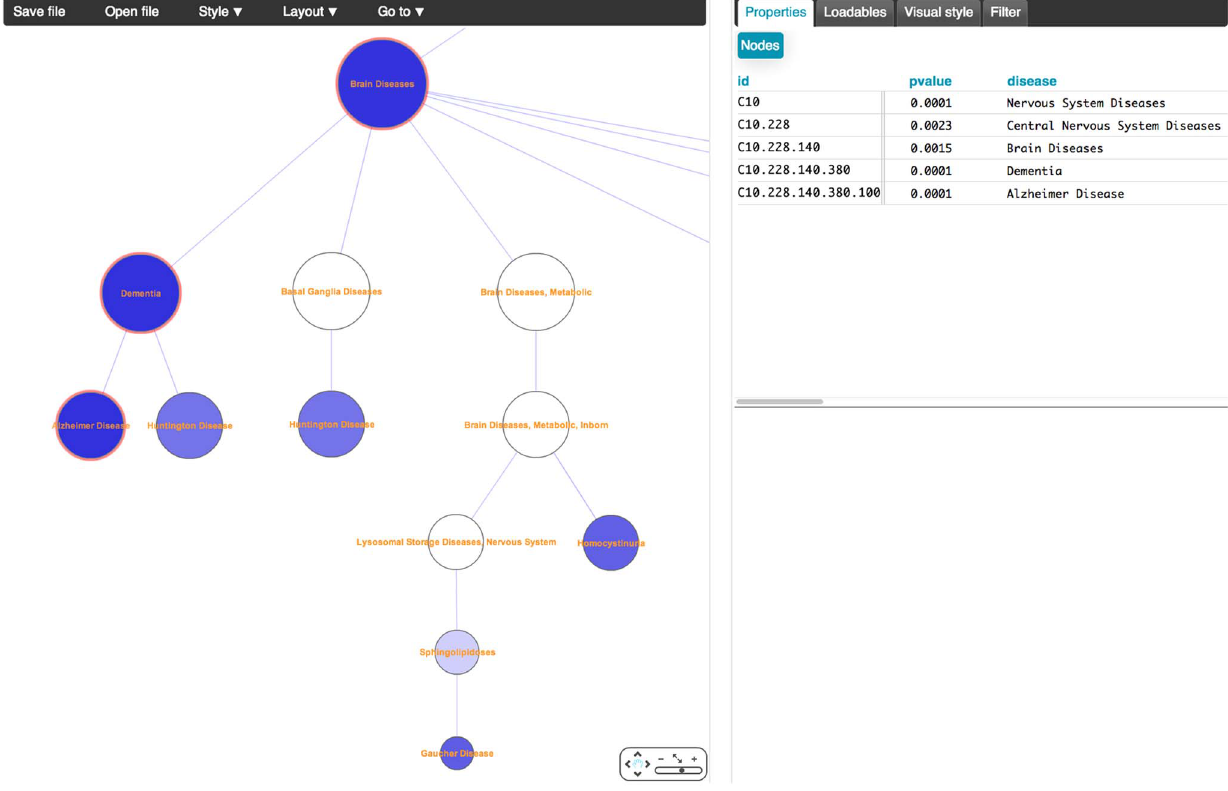
Figure 4. Detailed view of part of the Nervous System Disease subtree, showing enrichment of bone development genes. Links to dementia and Alzheimer’s disease are shown. Significance of each node in the tree is represented by color; a gradient of shades of blue indicates p- values ranging from 0 (darkest blue) to 1.0 (white). Clicking on a node or selecting a set of nodes allows users to see, in the box in the upper right corner, the selected disease terms, p-values, and genes shared between those diseases and the developmental gene set.